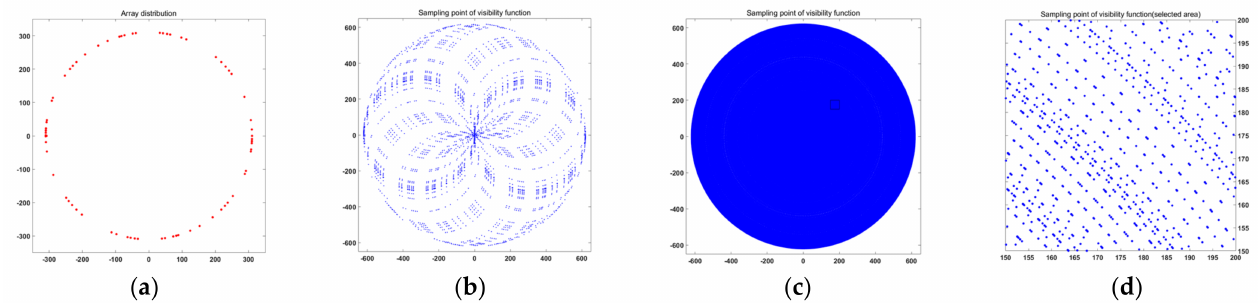
Figure 7. The antenna array ( a ) and resulting UV plane sampling pattern of the GIMS. ( b ) Snapshot samples, ( c ) the full samples after a rotation cycle, and ( d ) partial zoomed-in